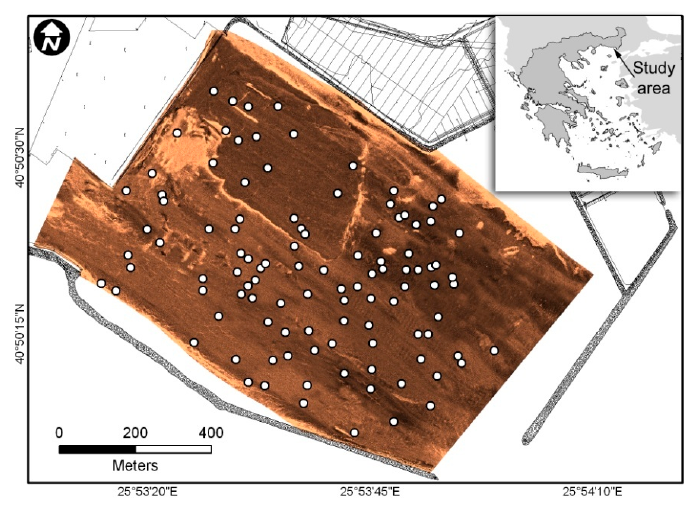
Figure 3. Map showing the Alexandoupolis Harbor, NE Greece, and the mosaic of the SSS imagery that has been used for the validation of the proposed automatic target detection system. The 71 small man made targets that have been manually detected are indicated with white circles.